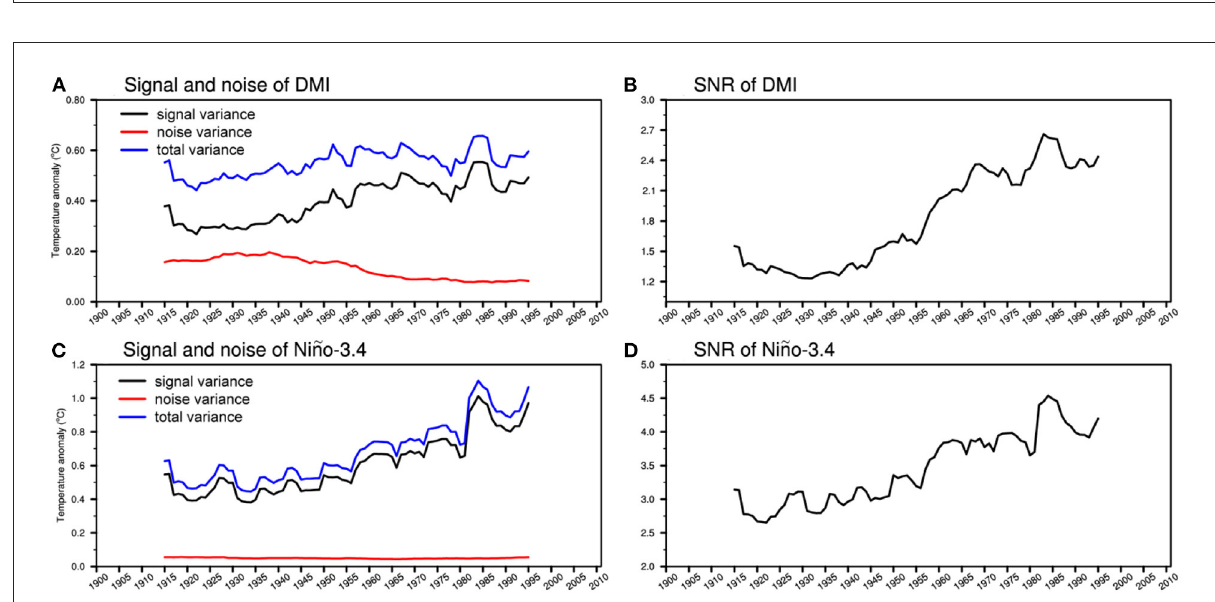
FIGURE5 (A) The total variance (blue line), and the variance of predictable signal (black line) and unpredictable noise (red line) of the predicted SON-mean DMI. (B) The signal-to-noise ratio (SNR) of the predicted SON-mean DMI. The variance and SNR are calculated by the 30-year moving window for the period 1901–2010. (C, D) as in (A, B) , but for the predicted SON-mean Niño-3.4